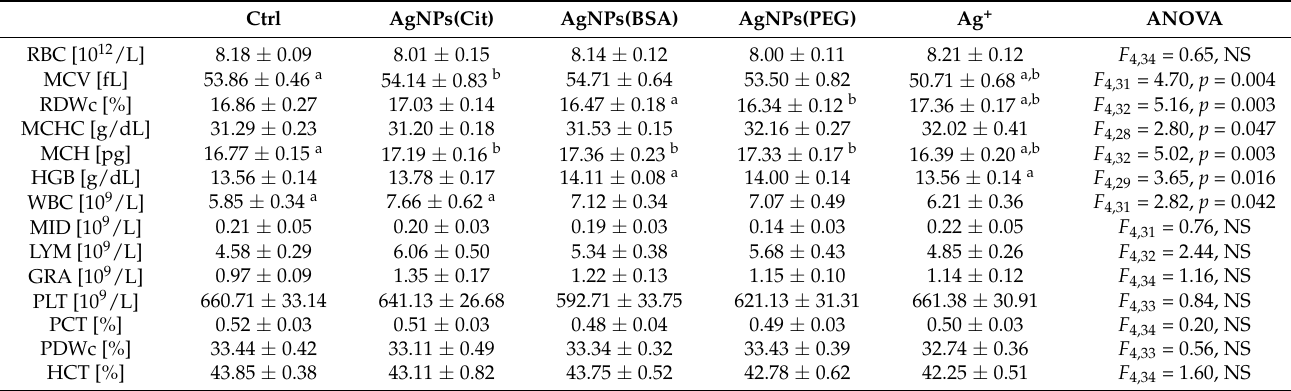
Table 1. Hematological values (mean ±